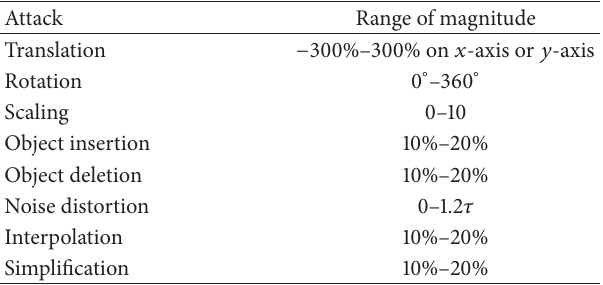
Table 1: Magnitudes of